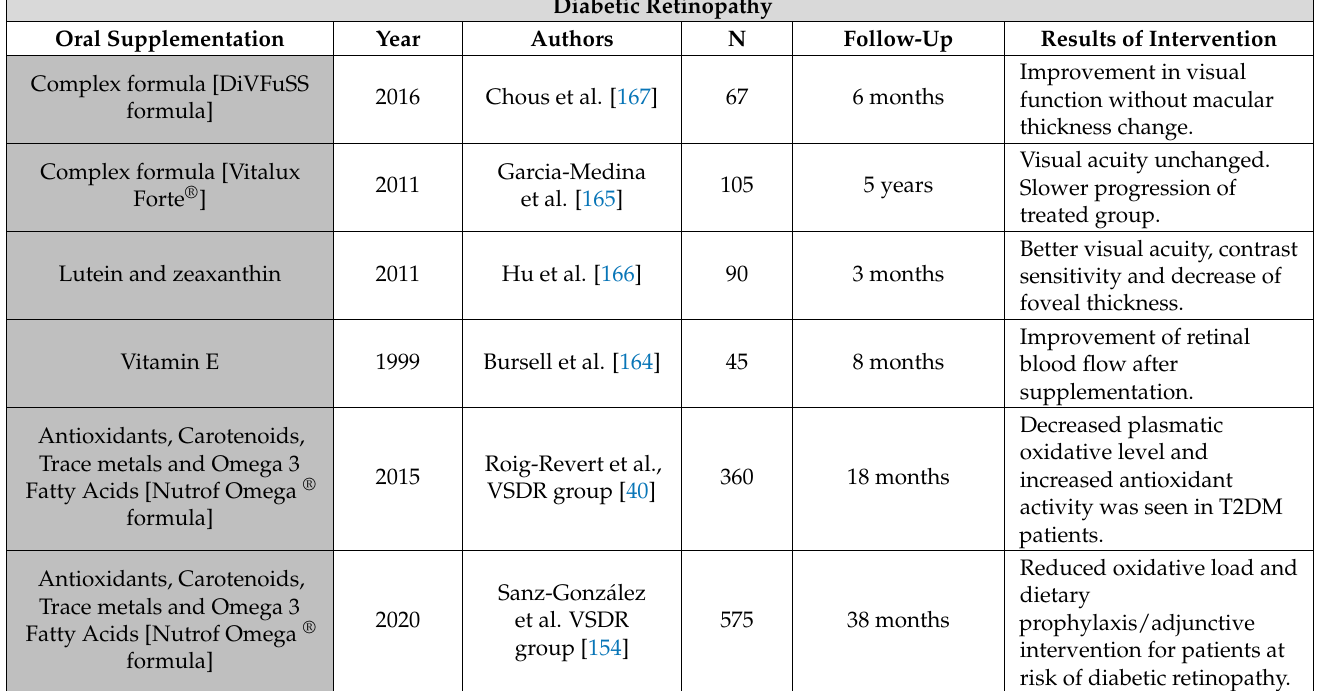
Table 4. Most relevant studies (alphabetically sorted by nutritional supplementation type) in diabetic retinopathy, glaucoma and ocular surface disorders/dry eye